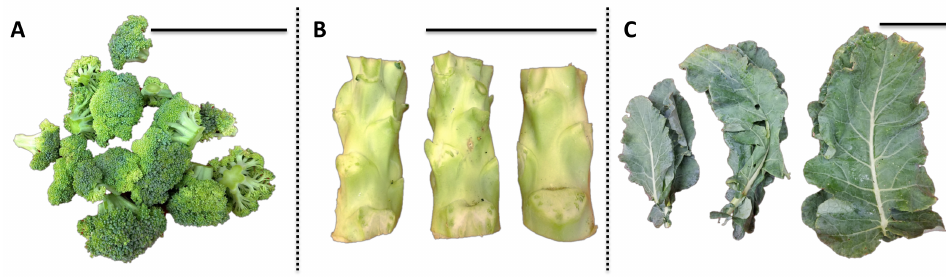
Figure 7. Representative image of various broccoli tissues for one biological replication. The black scale bar at the right upper corner of each picture is 10 cm. ( A ) Broccoli floret; ( B ) broccoli stem; ( C ) broccoli